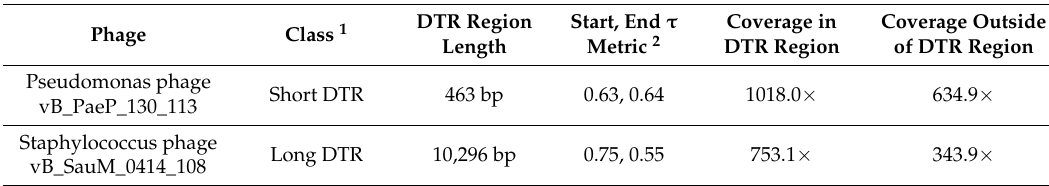
Table 3. Genomic termini statistics.